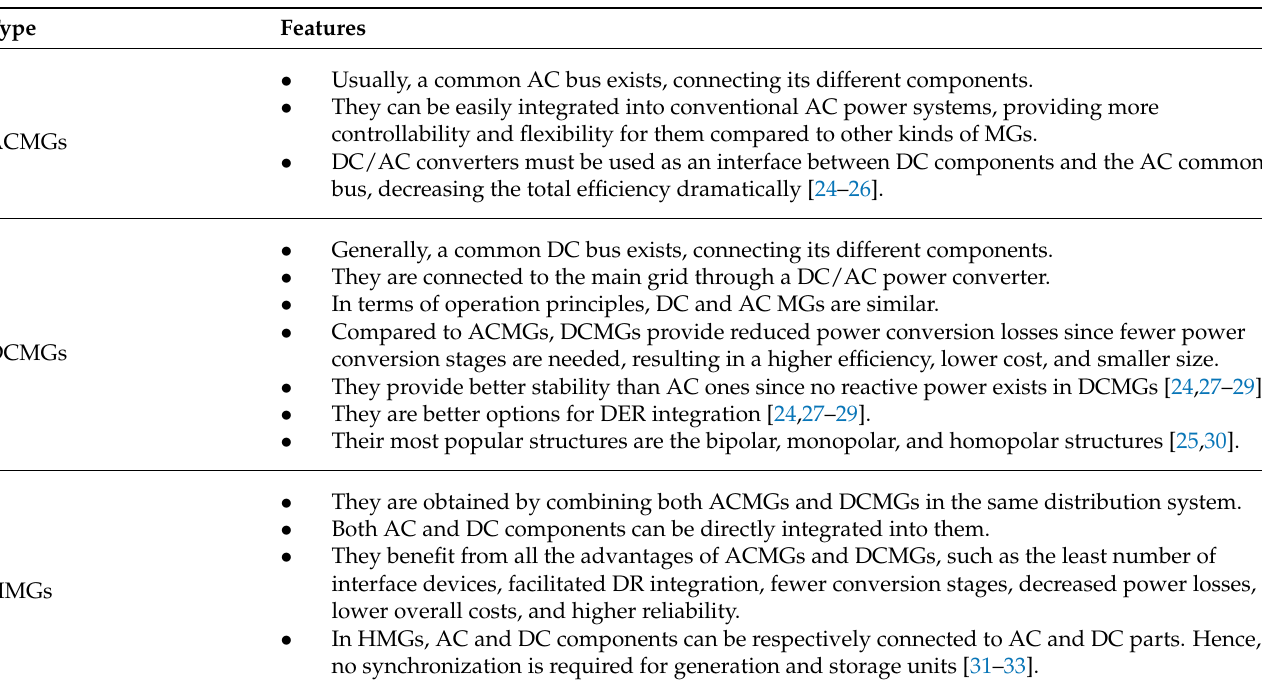
Table 4. Main characteristics of different components of an MG.